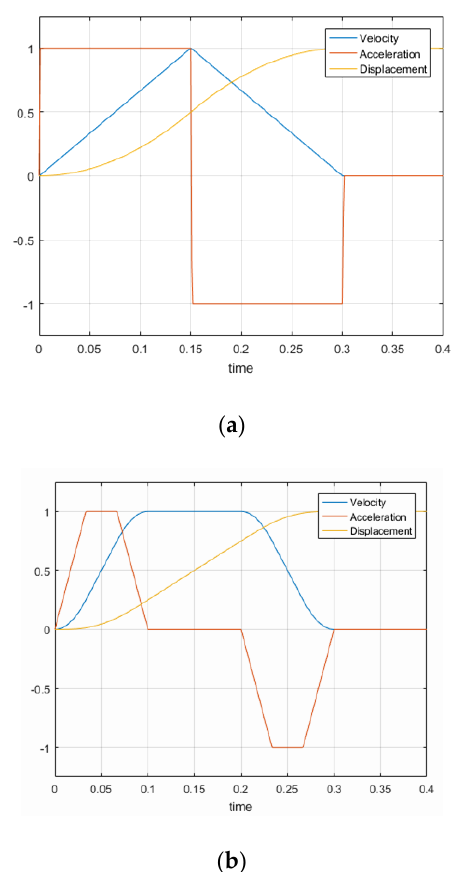
Figure 8. An example of a traffic profile with ( a ) a triangular velocity profile, ( b ) a velocity profile described by s-curves.